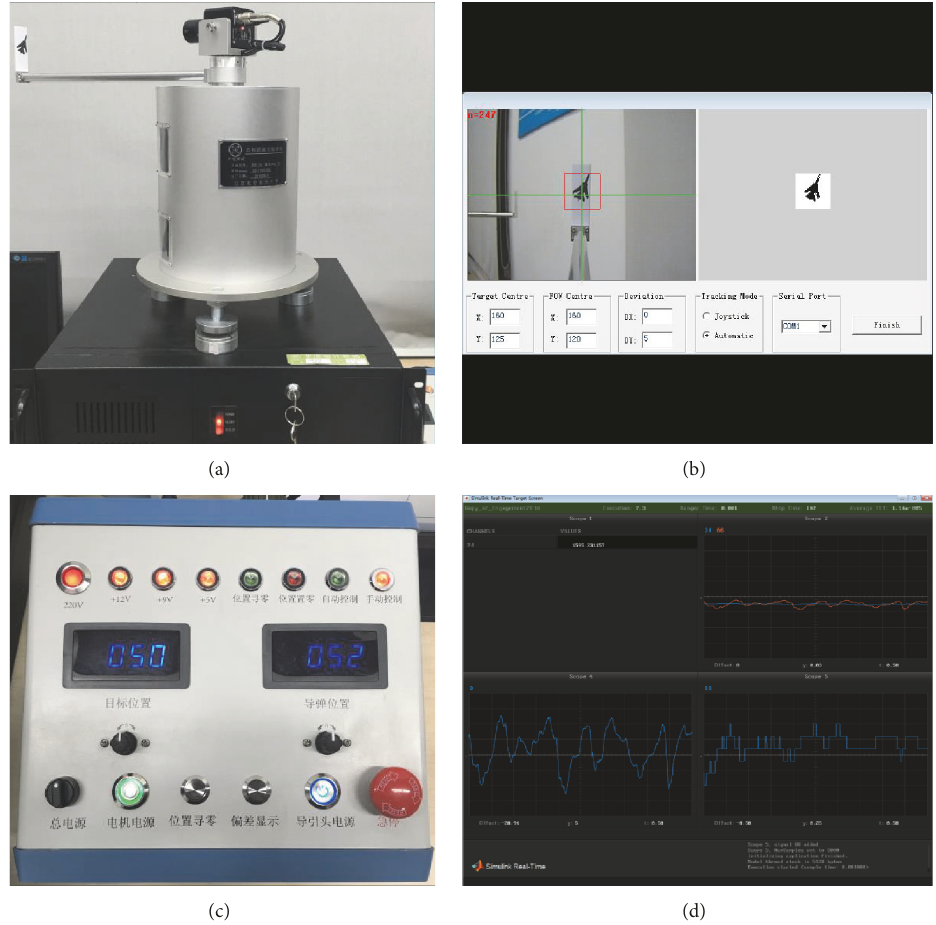
Figure 20: The platform is implementing the TV guidance